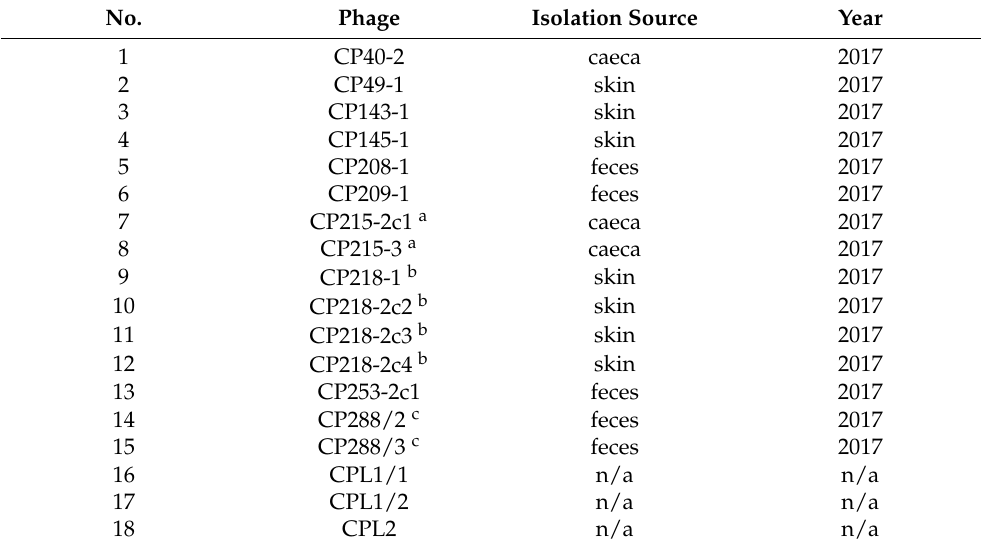
Table 1. Isolated phages, sample origin, and year of isolation. No.